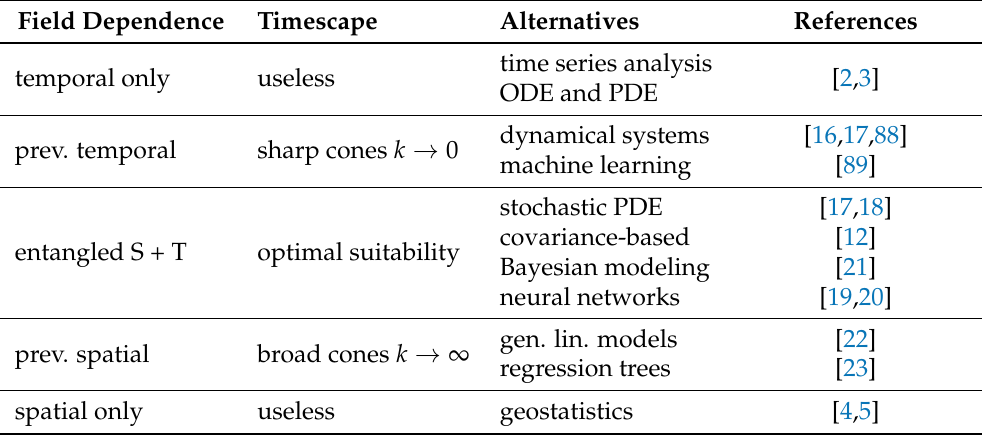
Table 5. Observations-driven decision tree. ODE/PDE = Ordinary/Partial Differential